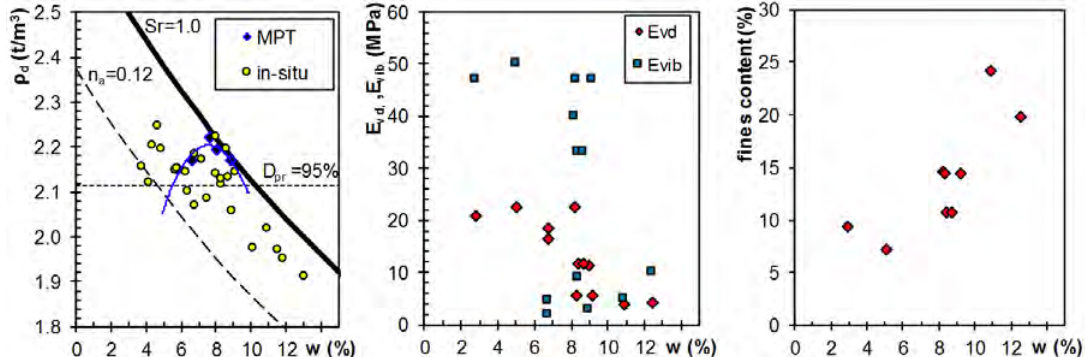
Figure 25. Results from the first test section. High water content in silty part of the mixture control the achieved stiffness and density. Evd – dynamic deformation modulus measured by dynamic load plate test; Evib – dynamic elasticity modulus of soil beneath drum (Terrameter CCC system).